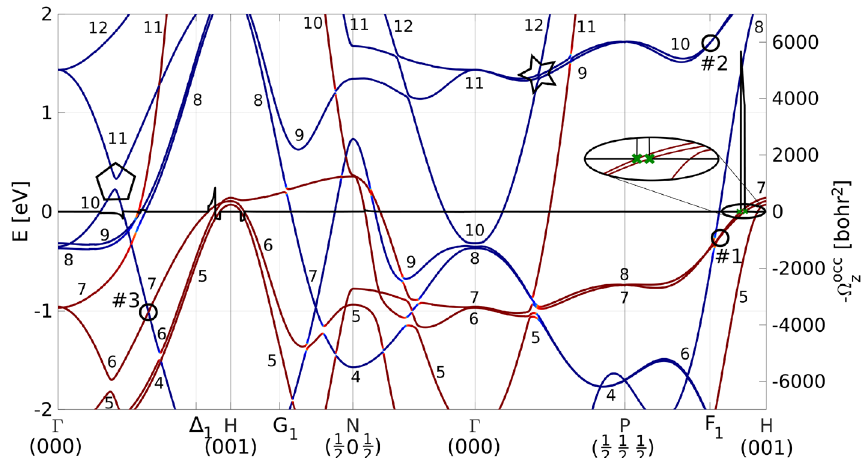
Figure 1. Conventional band structure of bcc Fe along a standard 1D-path in the Brillouin zone. Bands are indexed by their increasing energy value starting with 4 s bands. Three additional k -points are marked on the horizontal axis, namely � 1 = ( 0, 0, 0.8 ) , G 1 = ( 0.2, 0, 0.8 ) , and F 1 = ( 0.2, 0.2, 0.8 ) . The red (blue) color corresponds to spin down (up). The black curve is the z -component of the Berry curvature over occupied states = (cid:30) n (cid:31) occ n f n (cid:31) z . Selected Berry curvature monopoles are highlighted by circles and numbered. The investigated z contribution to the intrinsic AHE is marked by black ellipse. The green crosses mark k -points where bands 6 and 7 cross the Fermi level (zoomed). Pentagon and star highlight studied features of the electronic structure. All labels are in conjunction with Figs. 2, 3.